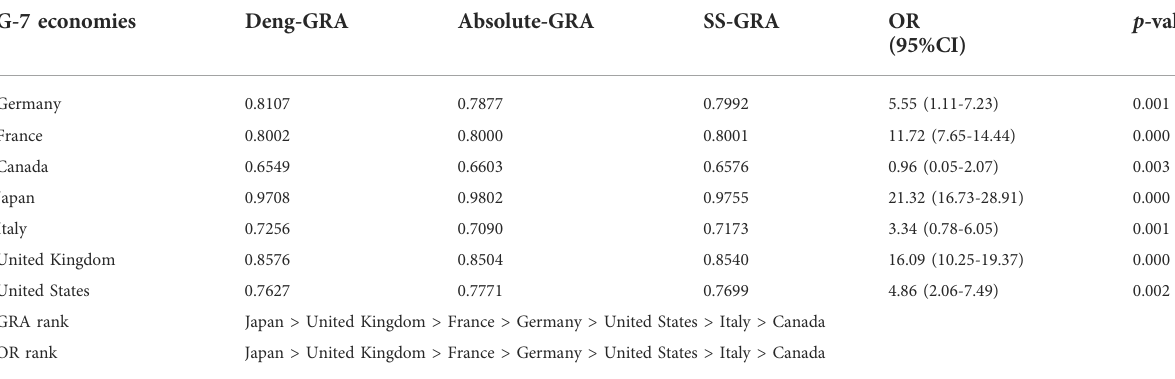
TABLE 3 Mathematical and statistical assessment between carbon emissions and